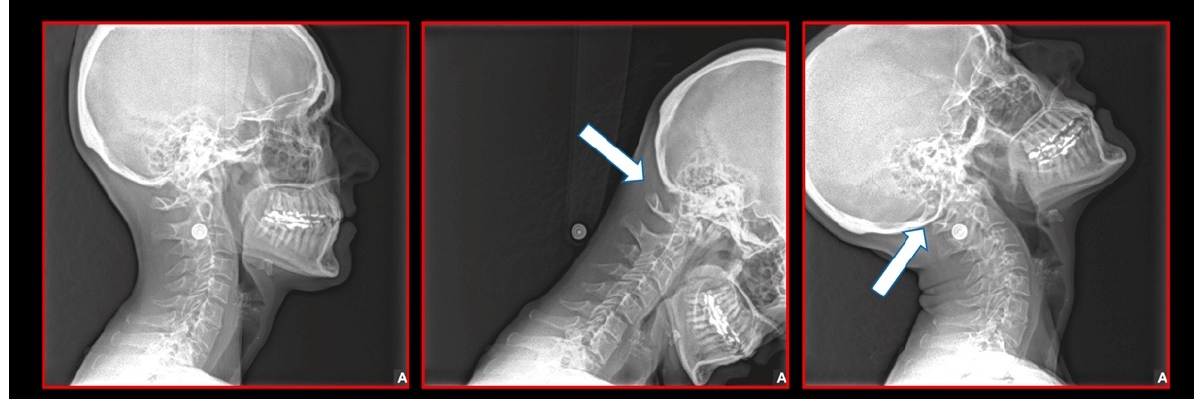
Figure 7. Normal lateral (sagittal) dynamic cephalometric analysis.